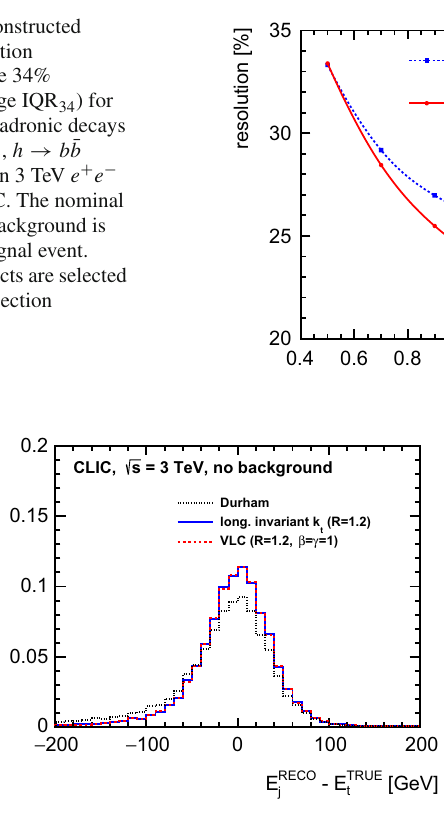
hadrons background are overlaid on the signal and particle-flow objects are selected using the tight selection